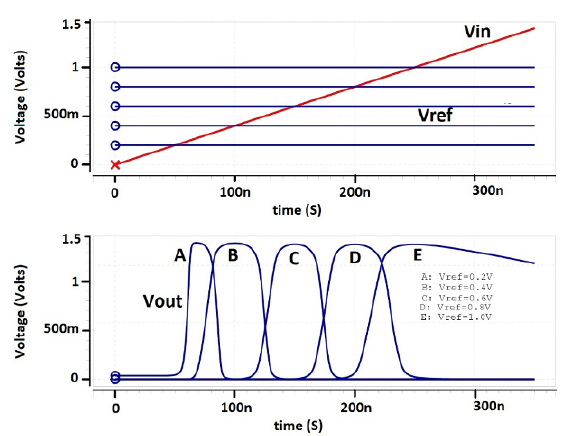
Figure 5. Manipulation of decison threshold with tail